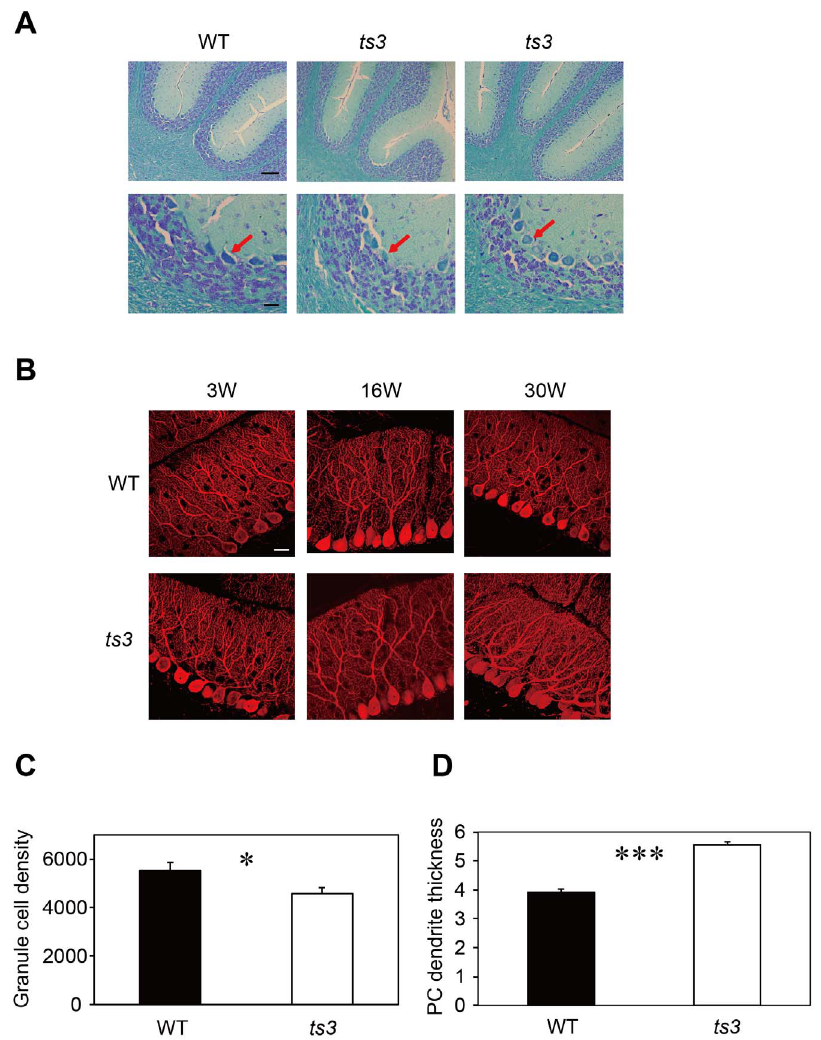
Figure 4. Morphological abnormality of Purkinje cells in ts3 cerebella. A) Kluver-Barrera’s stain was performed on ts3 and WT cerebella. Number and morphology of Purkinje cells were normal in ts3 mutants. In contrast, however, GC numbers were reduced, and the size of the nuclei was significant smaller than WT. Scale bars, 50 m m (upper panel); 20 m m (lower panel). B) Immunohistochemisty was performed on cerebella in ts3 and WT mice using anti-calbindin antibody as a Purkinje cell marker. Purkinje cell morphology became progressively altered commensurate with mouse age. Note that dendrites of ts3 Purkinje cells at 30 weeks of age look significantly thicker than their WT counterparts. Dendrite branching was also abnormal in ts3 mutants. Scale bar, 20 m m. C) Significant reduction in granule cell density (cell number/mm 3 ) in old ts3 mutants (30 weeks old). D) The PC dendrite is significantly thicker in ts3 mutants at 30 weeks of age (n=70 each, averaged diameters of the thickest regions). * P , 0.05, *** P ,